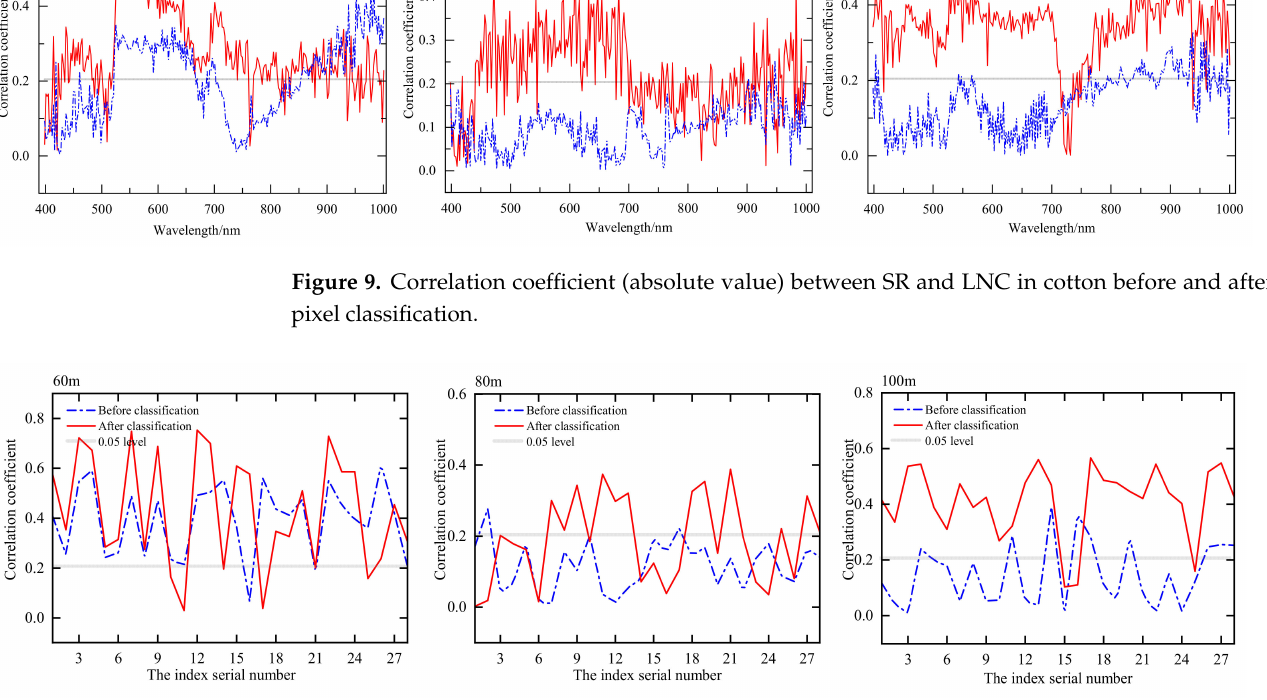
Figure 10. Correlation coefficient (absolute value) between vegetation index (VI) and LNC in cotton before and after pixel classification (the index was selected from another paper published by the au- thor, which has a good nitrogen response relationship proposed by predecessors, DOI:10.1007/s12524-